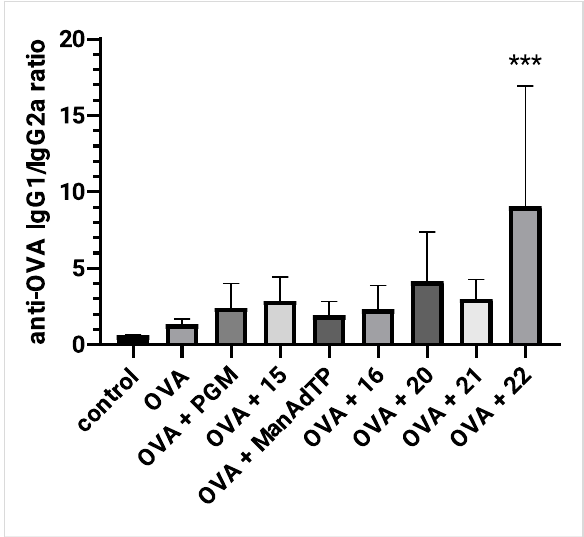
Figure 6: The ratio of anti-OVA IgG1 and anti-OVA IgG2a (IgG1/ IgG2a) in BALB/c mice. For each mouse serum IgG1/IgG2a was calcu- lated and the result for each experimental group ( n = 5) is presented as average ± standard deviation (SD). *** p < 0.001 denote statistical significance in comparison to the control